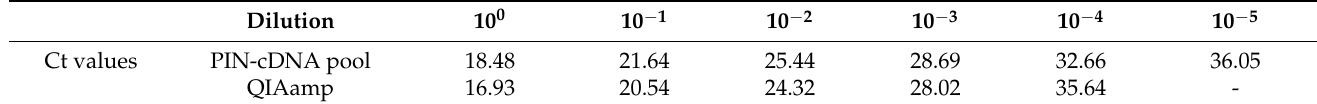
Table 4. The Ct values for a standard curve from a representative